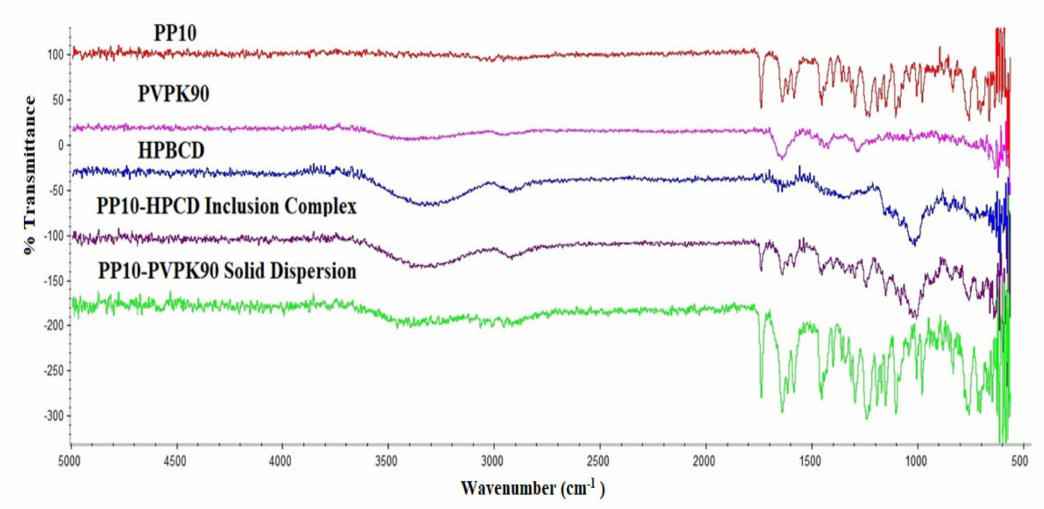
Figure 2. FT-IR spectra of PP10, PVP-K90, HP- β -CD, and PP10 binary systems. The powder X-ray diffractogram of PP10 displayed the presence of sharp diffraction peaks which is an indication of the crystalline nature of the drug (Figure 3). The diffrac- tograms of the binary systems were different from that of pure drug, which demonstrated peaks of lower intensity, disappearance, and formation of some new peaks. These ob- servations indicate partial conversion of PP10 in the binary systems from crystalline to amorphous